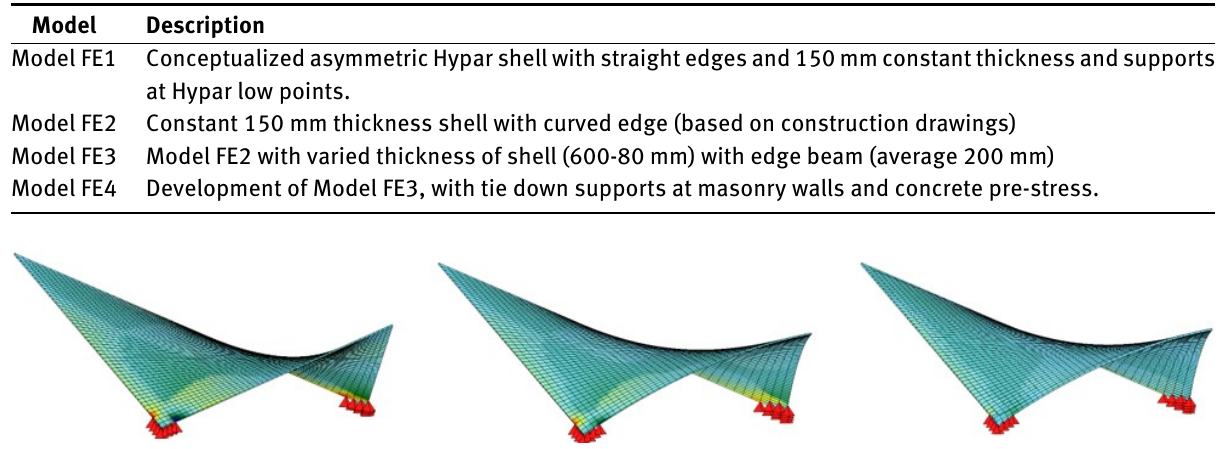
Figure 11: Overview of Finite element models FE1 (left), FE2 (middle) and FE3 (right)